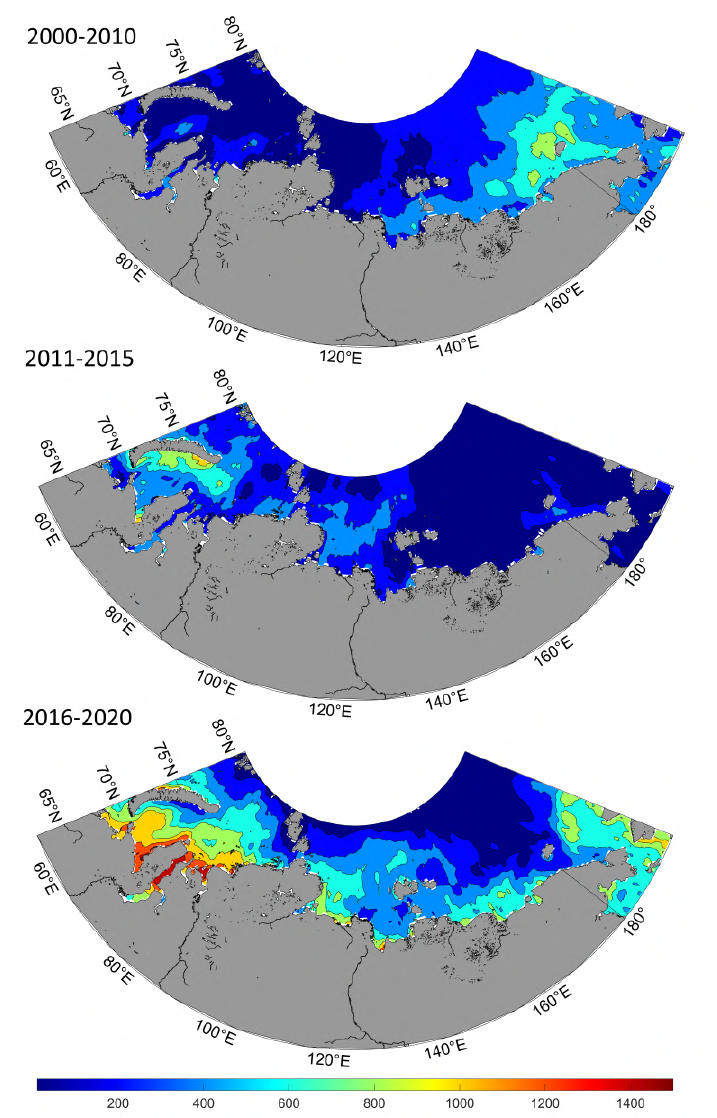
Figure 6. Intensity composite index ICI ( ◦ C · days) for the Siberian Arctic seas in 2000–2010, 2011–2015 and 2016–2020, based on detrended time